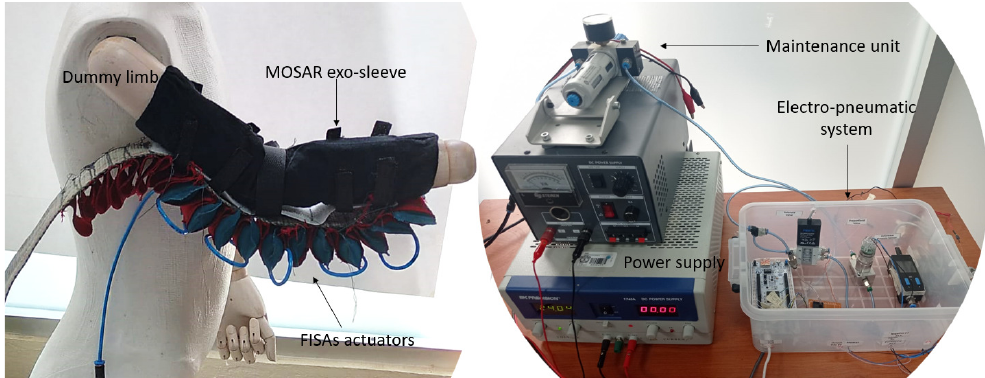
Figure 6. Experimental setup of FISAs above the MOSAR system with all the